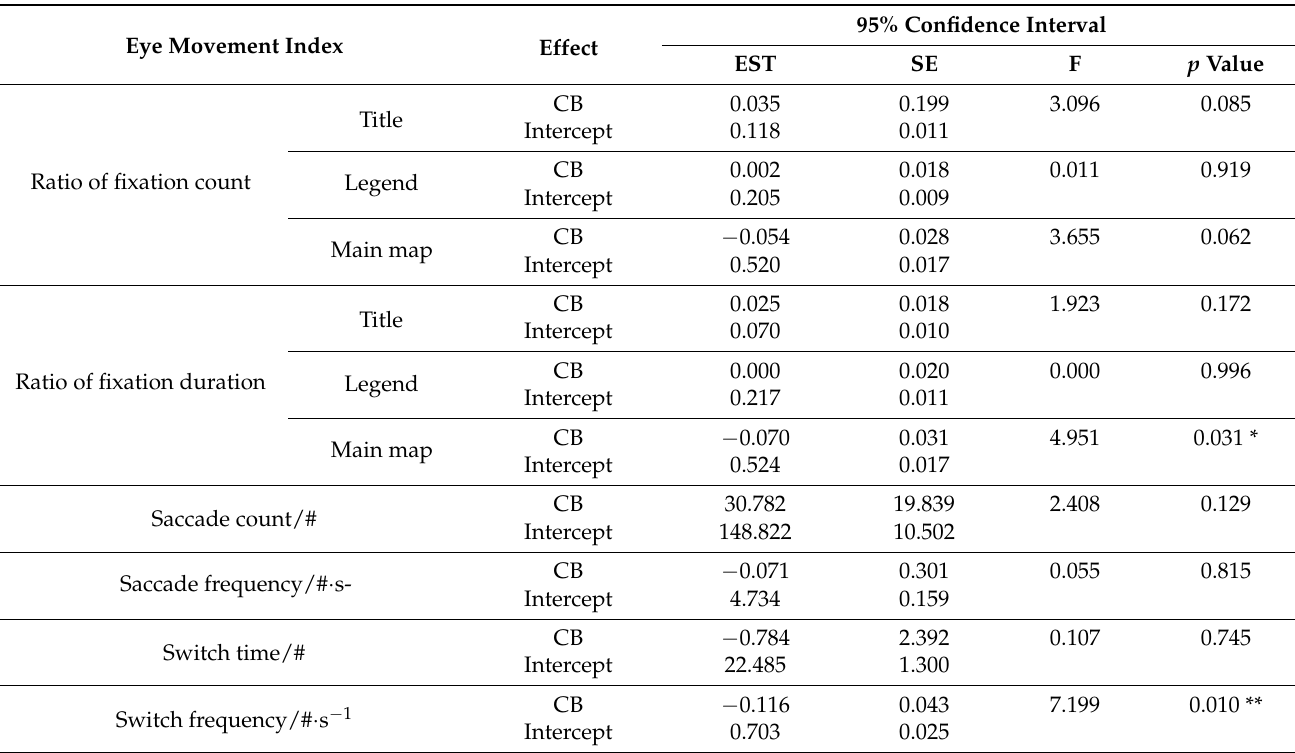
Table A4. Linear mixed model regression results in the spatial correlation task (CB, cultural